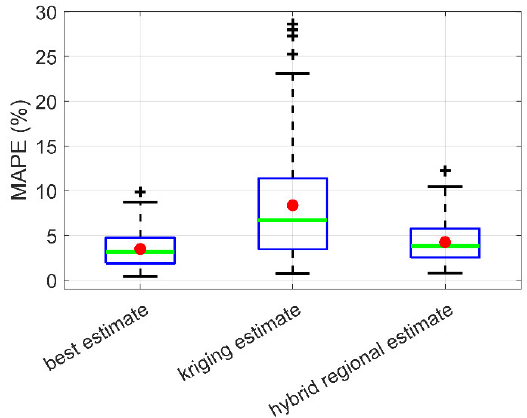
Figure 4. Boxplots showing the variability of the MAPE of the three procedures for all the automatic stations in the region for all sub-hourly durations; circles indicate the mean values. The central lines in the box indicate the median, and the box edges are drawn at the 25th (p 25 ) and 75th (p 75 ) percen- tiles. Values were considered outliers if they were larger than p 75 + 1.5(p 75 − p 25 ) or smaller than p 25 − 1.5(p 75 − p 25 ), and the whiskers extend to the most extreme data values after excluding the outliers. At sub-hourly durations, the only outlier in the best estimate approach is due to the overestimation of the observed mean value of annual maximum at 10 minutes for an au- tomatic station located in a plane area of the region. The only outlier shown by the new hybrid regional procedure is due to a systematic overestimation of the mean values at all sub-hourly durations in a foothills area. Both outliers refer to overestimation errors that, for the purposes of the current analysis, are conservative; thus, no actions or corrections are needed. The four outliers in the kriging estimate concern sites located in areas charac- terized by peculiar local topographical conditions that affect the observations. However, in these cases the estimation errors are conservative as well, as the kriging estimator over- estimates the observed value. The combination of mechanical and automatic stations in the proposed hybrid ap- proaches allows more reliable maps of mean annual rainfall maxima at sub-hourly scales to be obtained for the study region; an example is shown in Figure 5. The mechanical stations, in fact, provide additional information in those portions of study region where the density of the automatic stations is low. Figure 5 shows examples of maps of mean annual rainfall maxima at two sub-hourly durations, 20 and 40 minutes, obtained from ordinary kriging applied to the unified database of mechanical and automatic stations.